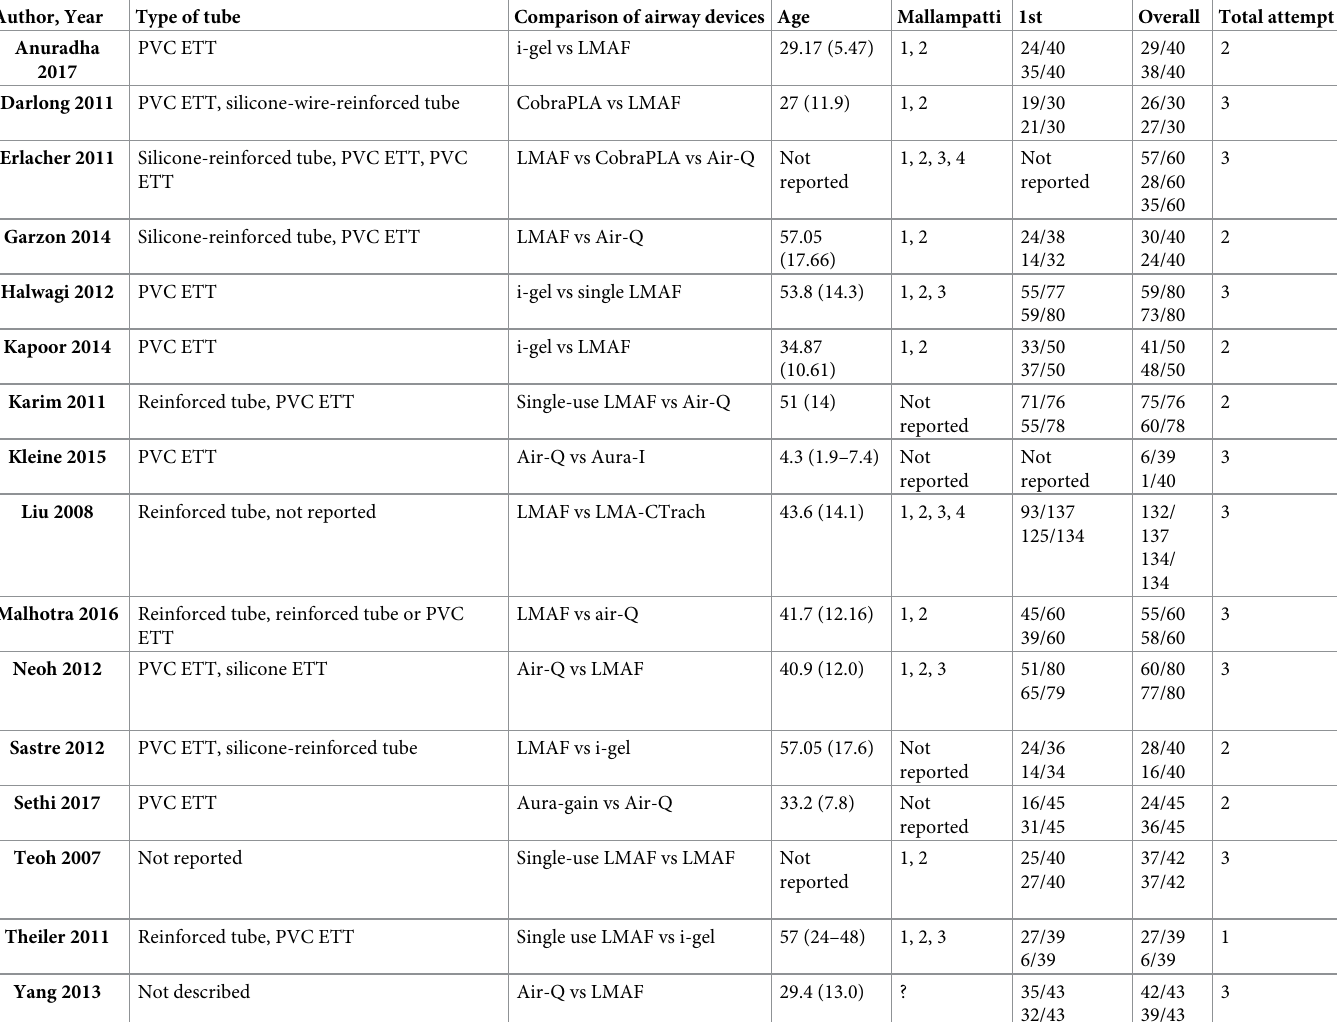
Table 2. Characteristics of the included randomized controlled